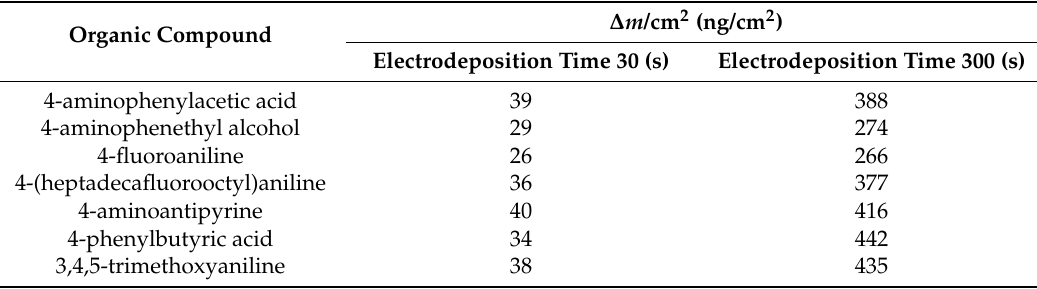
Table 1. The mass of the electrodeposited organic layers measured using